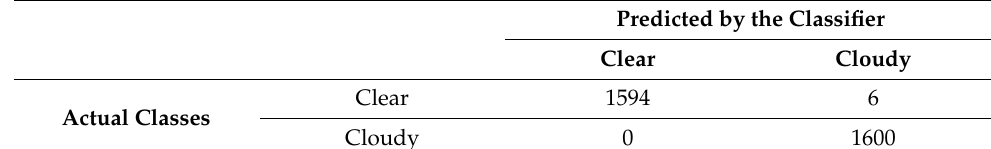
Table 2. Confusion Matrix Summary of Prediction Performance.